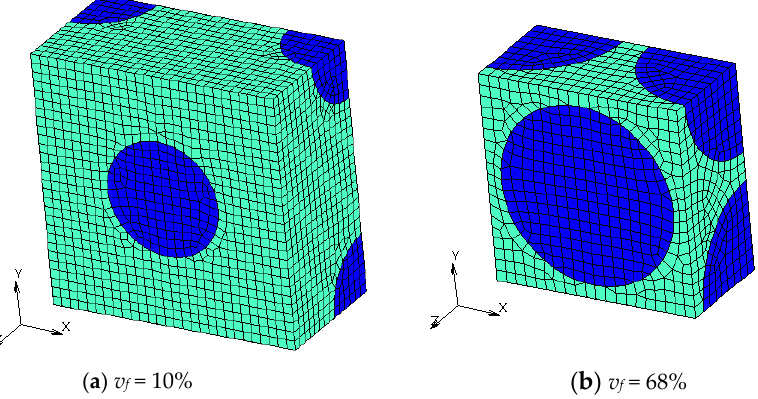
Figure 6. Numerical models of BCC microstructures with different volume fractions v f .